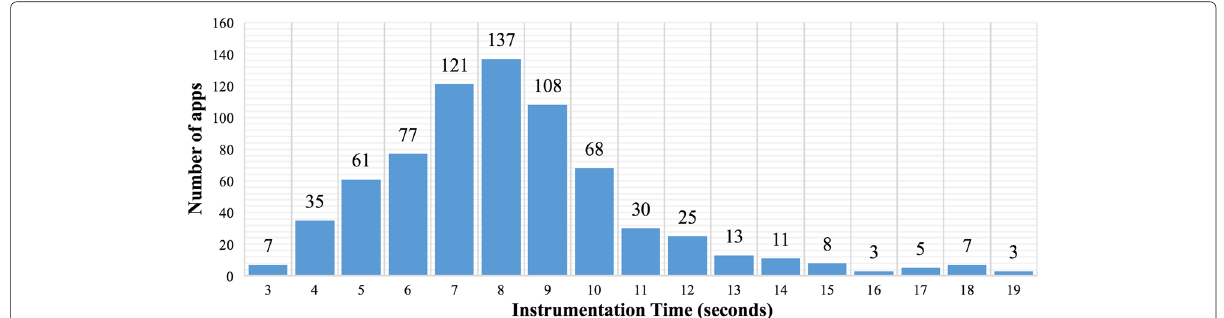
Fig. 4 Instrumentation time. The number of apps instrumented in different time. Most apps are instrumented in 7, 8, and 9